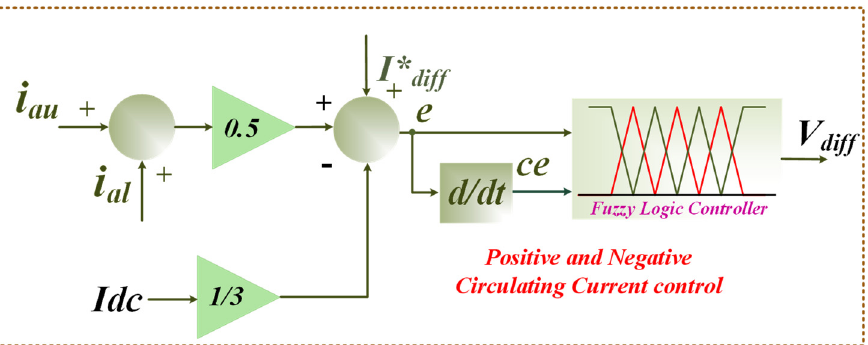
Figure 11. Proposed fuzzy logic control of circulating current in MMC.